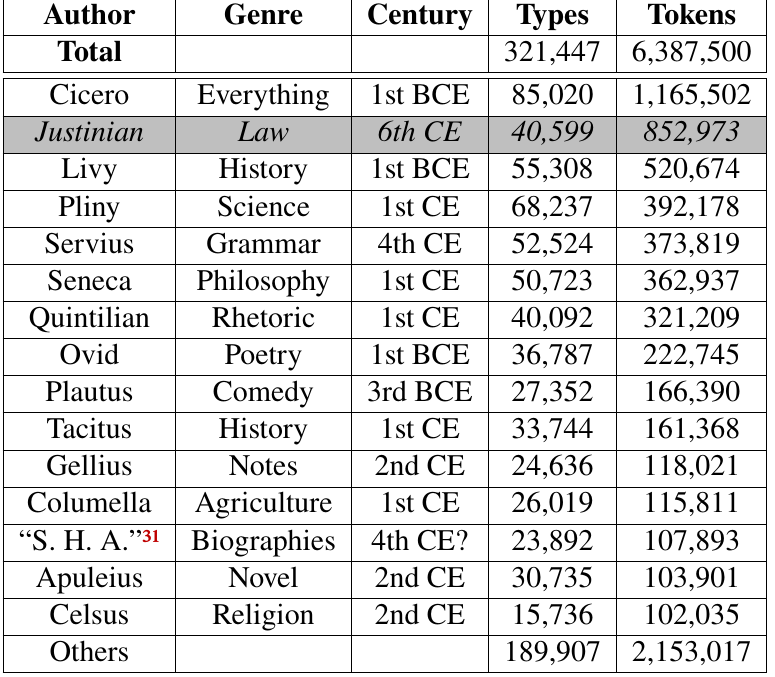
Table 1. The composition of the